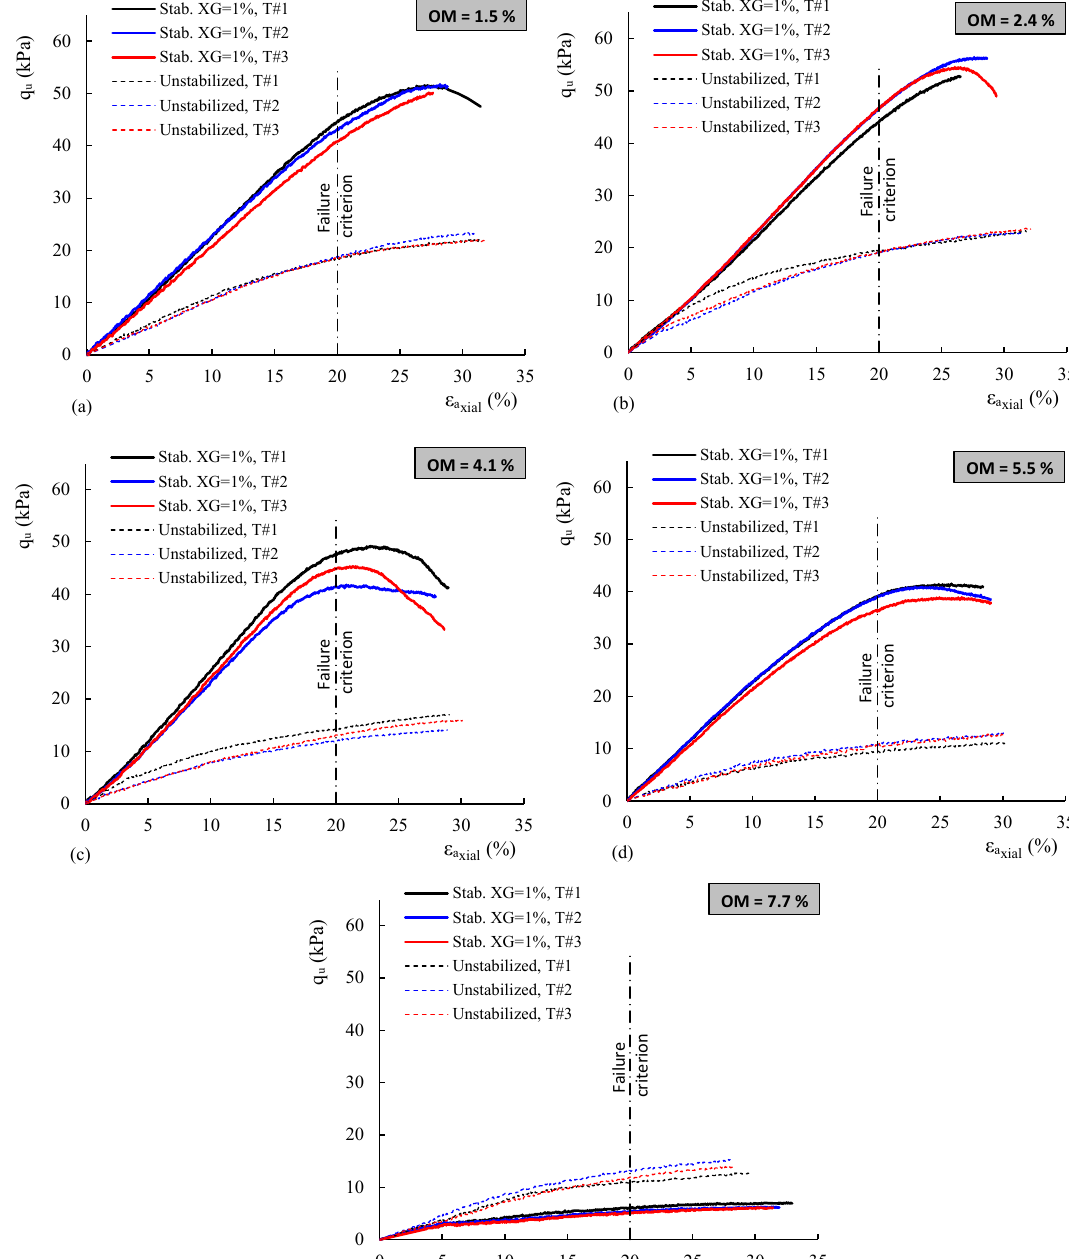
Figure 3. UCS tests. Effect of organic matter content on the stress-strain behavior: ( a ) OM = 1.5%; ( b ) OM = 2.4%; ( c ) OM = 4.1%; ( d ) OM = 5.5%; ( e ) OM = 7.7%.